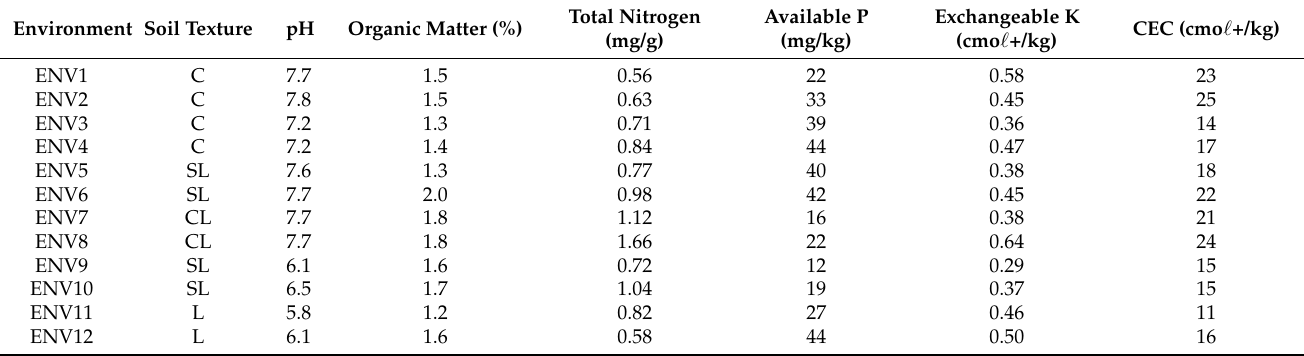
Table 3. Physicochemical properties of soil for the 12 environments. C, clay; SL, sandy loam; CL, clay loam; L, loam; CEC, cation exchange